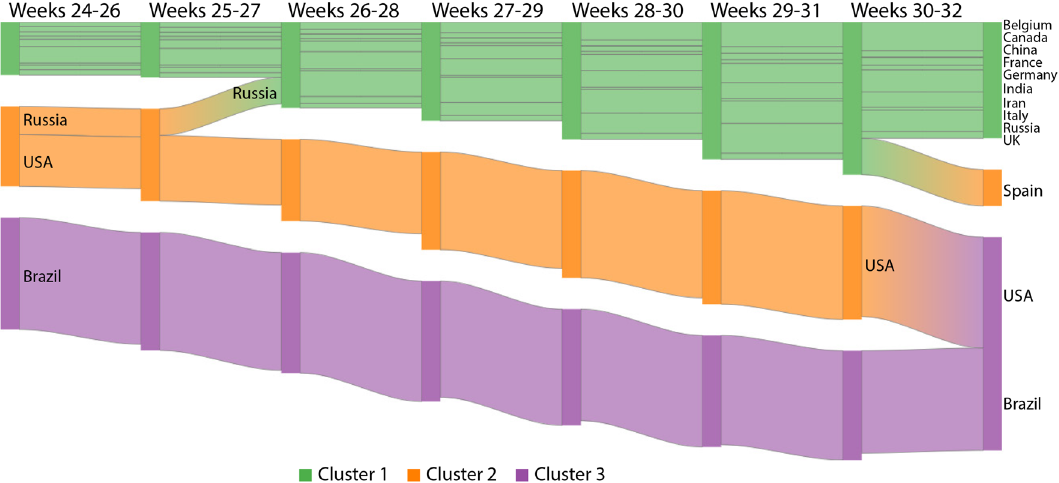
Figure 10. Confirmed cases for weeks 24–32 given no relevant change was observed later: visualization of the temporal transition of countries between pairs of clusters. Green, orange and purple correspondingly map the low, medium and high-incidence groups. This chart was generated by using Google Charts (https:// devel opers. google. com/ chart, version